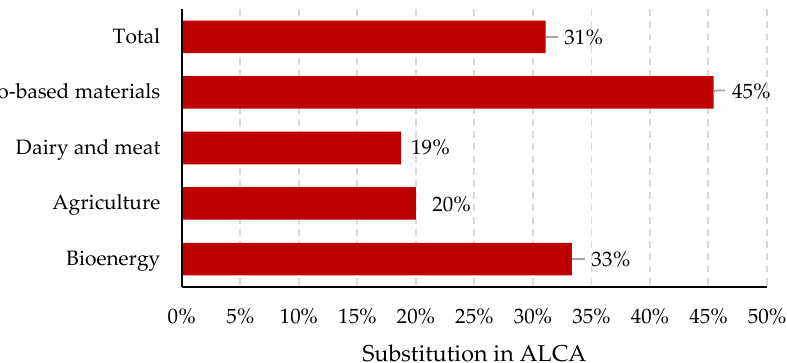
Figure 4. Percentages of self-declared attributional studies (ALCAs) which applied substitution as a system expansion approach. Only the sectors with a significant amount (more than 10) of self-declared attributional studies are included in this graph.